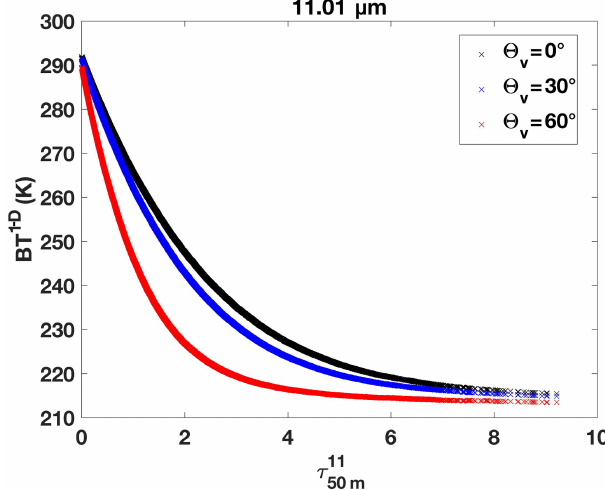
Figure 11. One-dimensional brightness temperatures as a function of the 50m optical thickness τ 1-D for viewing zenith angles (cid:50) v = 50m 0, 30 and 60 ◦ at a constant view azimuth angle of 0 ◦